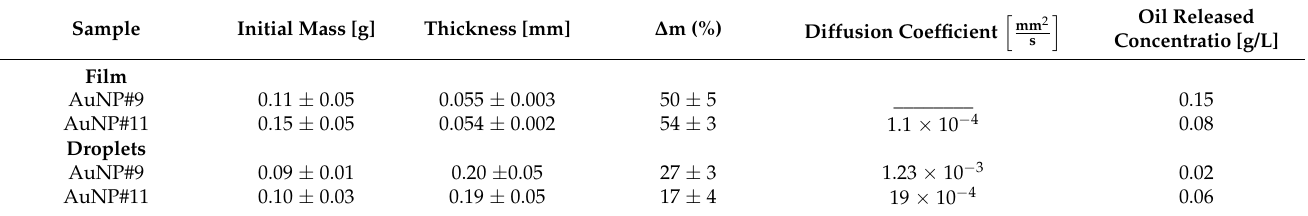
Table 2. Summary of the controlled release results of AuNP#11- and AuNP#9-films and